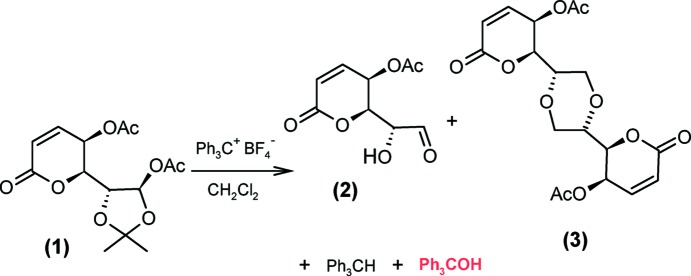
Synthetic step from which tri­phenyl­methanol was crystallized. Note that product (2) was not obtained.